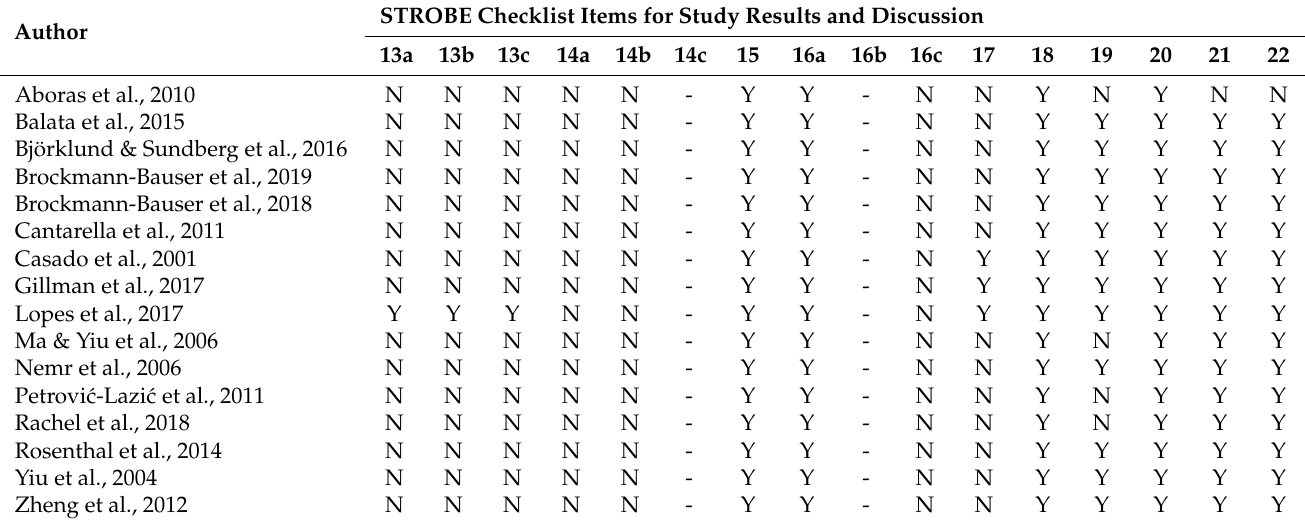
Table 7. Quality assessment for observational studies: results and